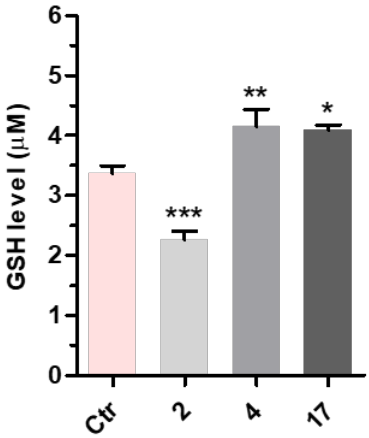
Figure 7. Effects of compounds 2 , 4 and 17 on GSH levels in SH-SY5Y cells. Cells were incubated with compounds 2 , 4 and 17 (1.25 µM) for 24 h. At the end of incubation, GSH levels were detected using the fluorescent probe MCB, as described in the Materials and Methods section. Data are expressed as concentration of GSH (µM) and reported as mean ± SEM of three independent experiments (* p < 0.05, ** p < 0.01 and *** p < 0.001 vs. control at one way ANOVA with Dunnett post hoc test).